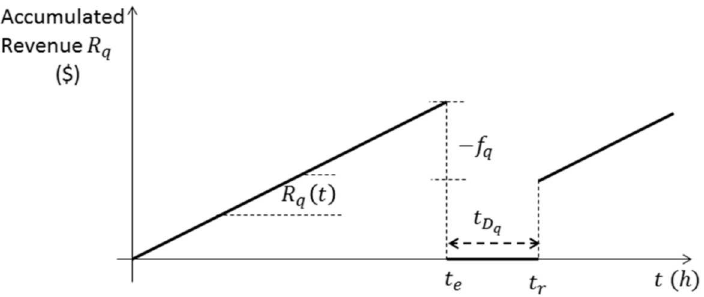
Figure 1. Behavior of the accumulated revenue R q in relation to occurrence of the accidental